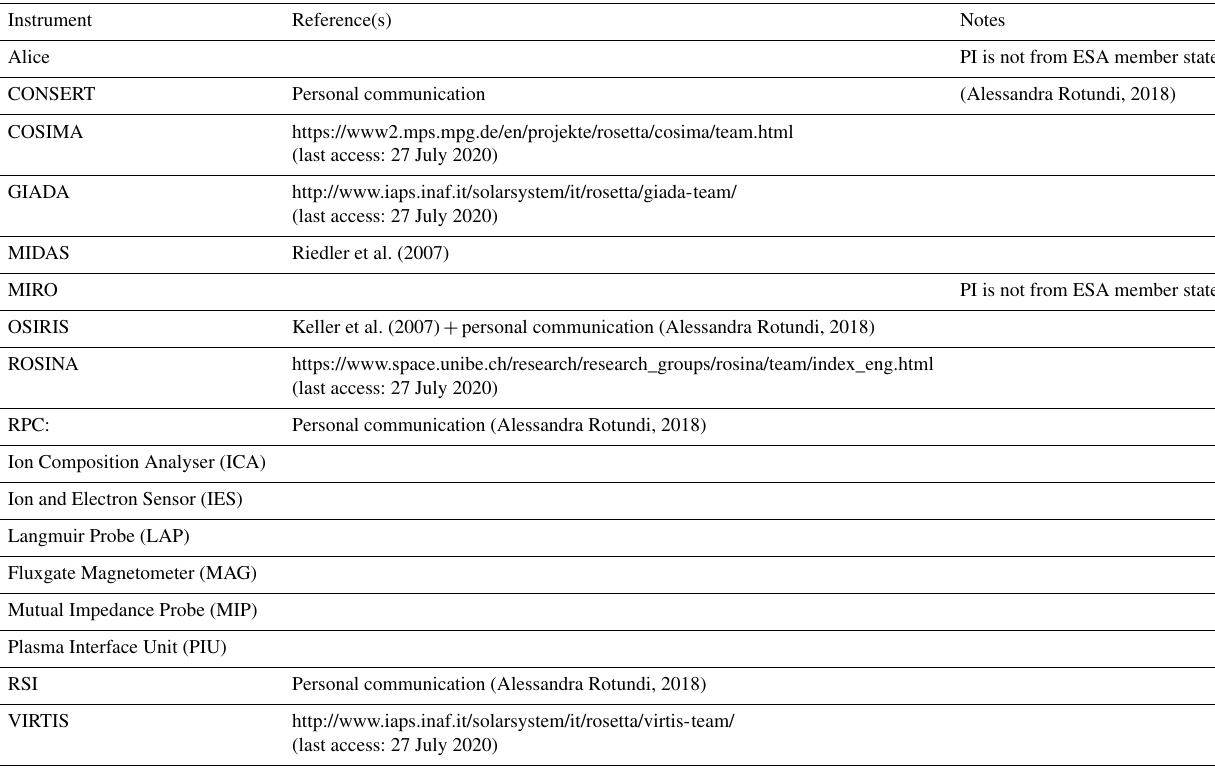
Table A2. Rosetta’s instruments and references for team members lists.